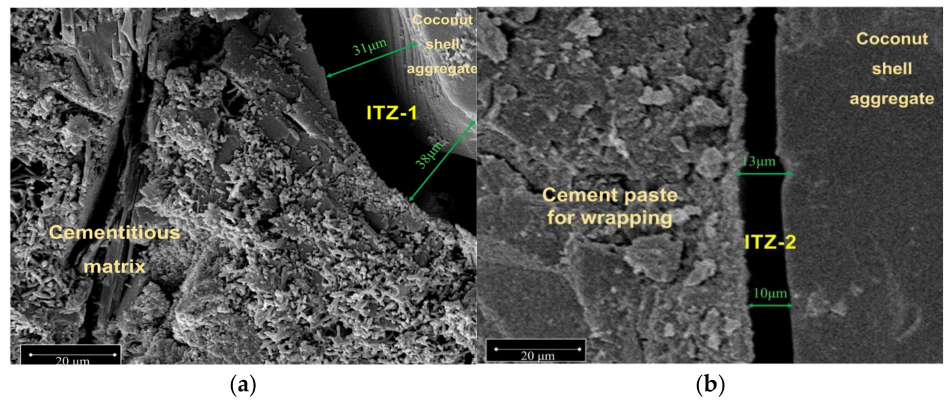
Figure 5. ( a ) The ITZ between the cementitious matrix and coconut shell in CCSAC at age of 28 days. ( b ) The ITZ between the cement paste for wrapping and coconut shell in SBRAC at age of 28 days. At the age of 3 days, the SBRAC only had a few aggregate failures on the compressive